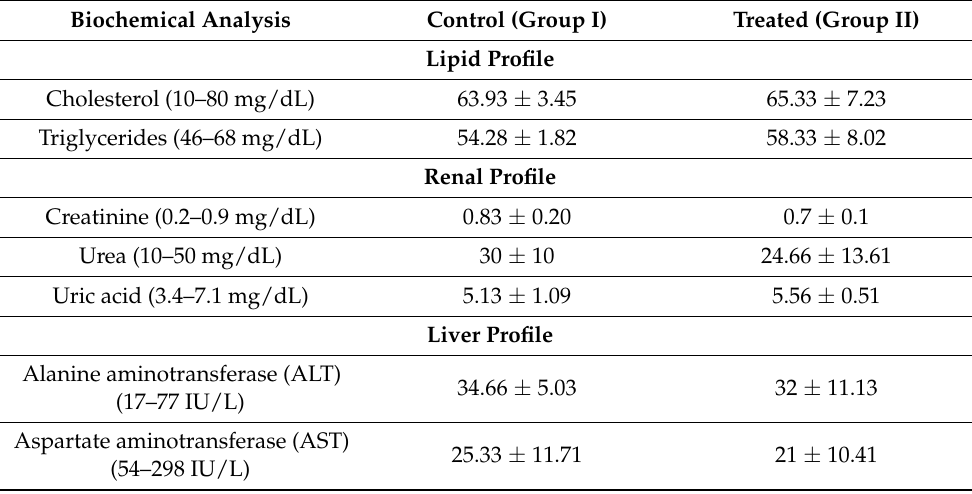
Table 7. Lipid, kidney, and liver function test.